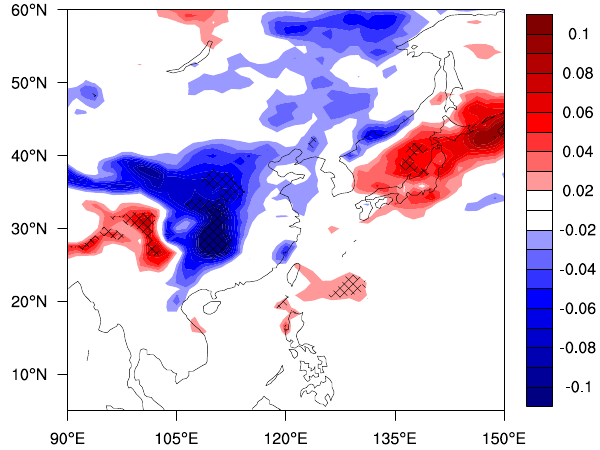
Fig. 9. Change of low cloud fraction due to black carbon changes (Control minus BC 1950) in September. Units: 1. Significant changes excess 95% confidence level are hatched.